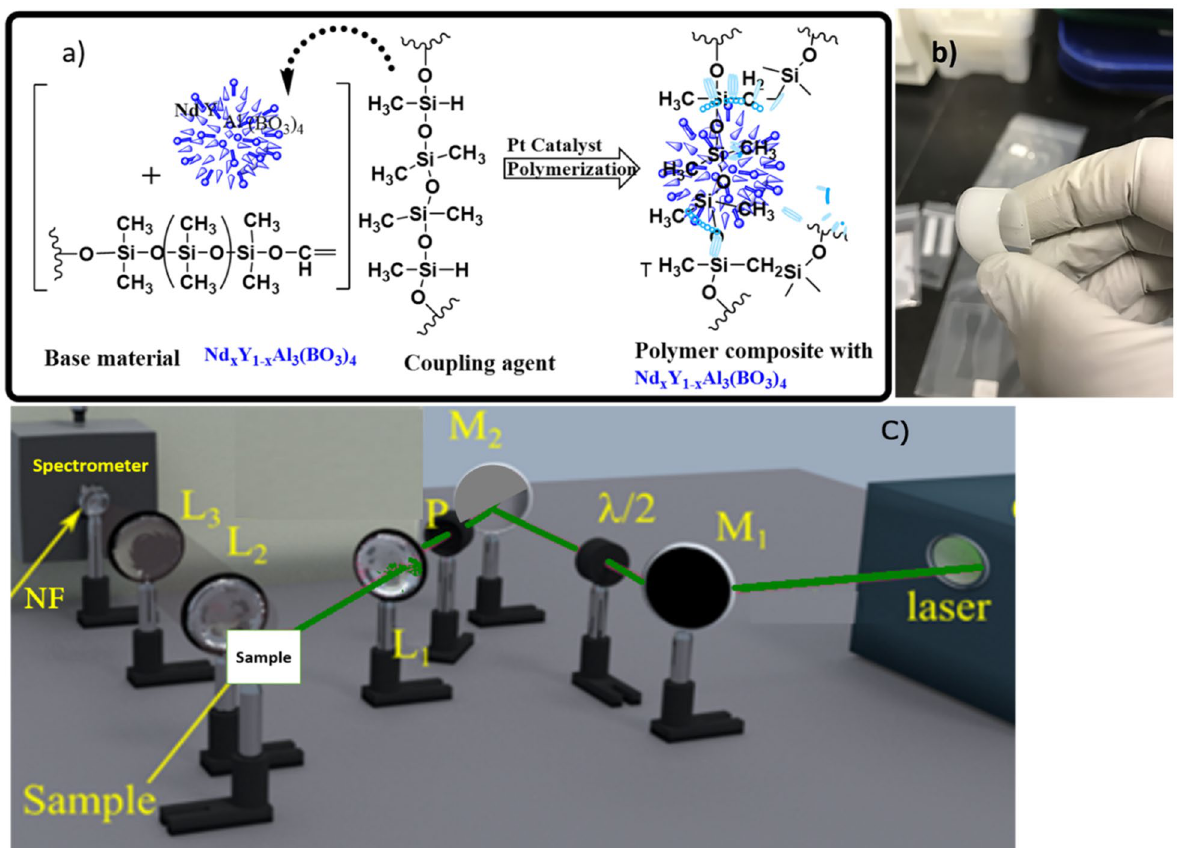
Figure 5. ( a ) The composition of the polymer composite, and ( b ) THE synthesized flexible polymer composite, ( c ) Experimental setup used to excite the samples and collect the RL emission. The source of excitation is a Nd:YAG laser at 532 nm. The beam intensity is controlled through a half-wave plate (HWP) and a polarizer (P) and is focused on the sample by lens L 1 . The light signal is collimated by lens L 2 and focused on the spectrometer entrance by lens L 3 . The signal is detected using a